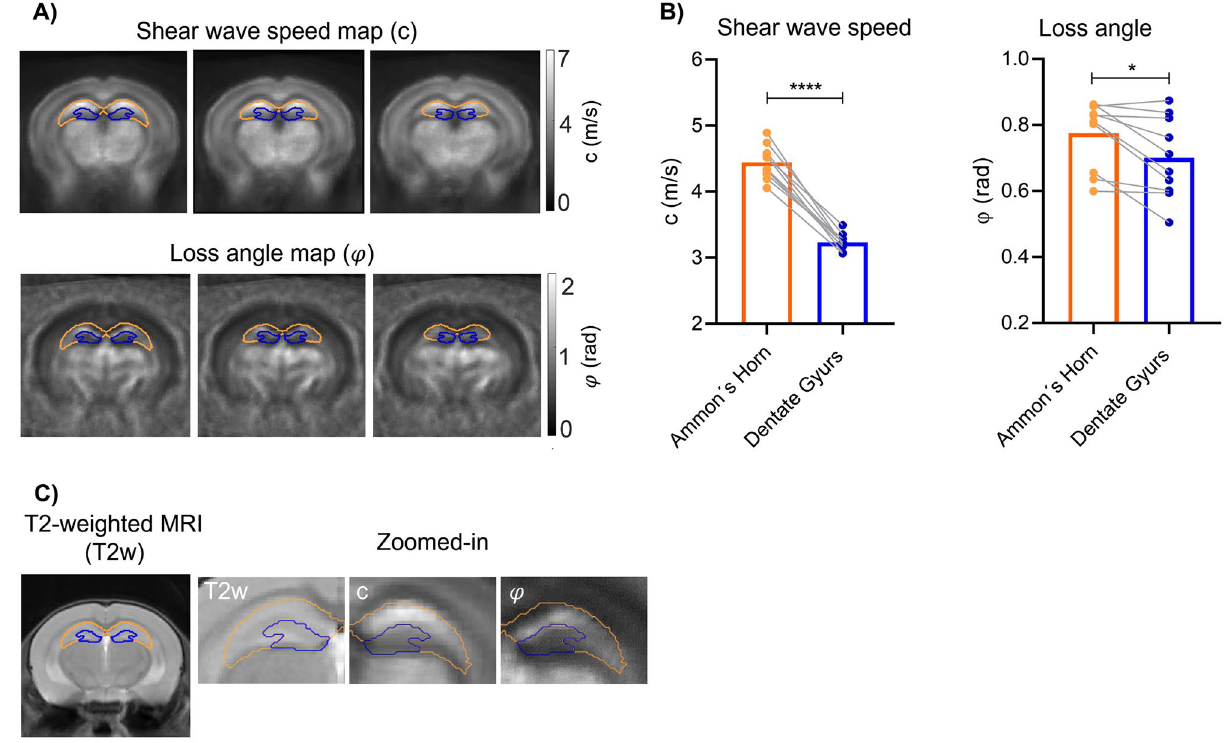
Figure 3. Regional in vivo MRE results. ( A ) Representative group averaged c- and φ-maps with Ammon´s horn (orange) and dentate gyrus (blue) masks. Image slices with distances of 210 µm correspond to the Bregma areas − 2.49, − 2.28 and − 2.07. ( B ) Group values of c and φ for Ammon´s horn and dentate gyrus (n = 10, *p = 0.0102, ****p < 0.0001). ( C ) T2-weighted MRI for anatomical orientation with magnifications of parameter maps and masks in the hippocampal